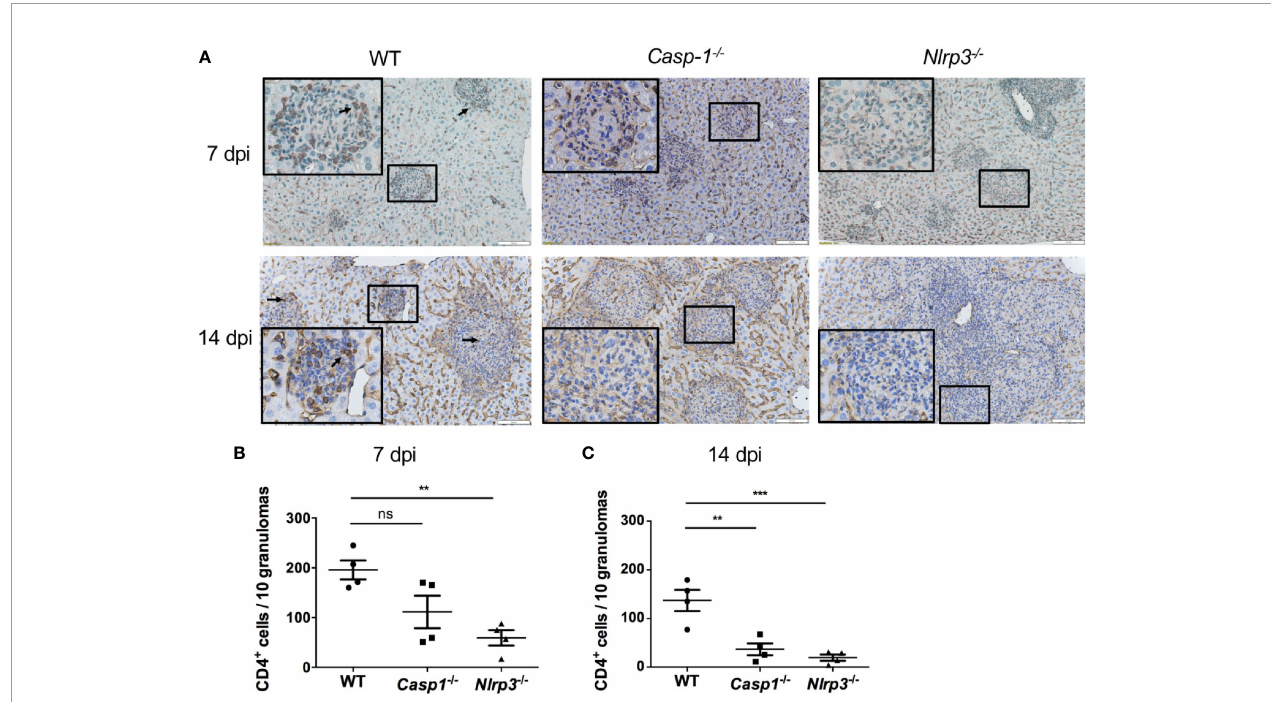
FIGURE 6 | The de fi ciency of Caspase-1 and NLRP3 undermines the recruitment of CD4 T cells into granulomas in murine liver. (A) Representative CD4 staining graphs of murine livers of WT, Casp-1 -/- and Nlrp3 -/- mice intravenously infected with live T. marneffei yeasts (5x10 5 CFU per mouse) at 7 dpi and 14 dpi. Scale bar denotes 100 m m. The insets indicate the magni fi ed area of the smaller box containing granulomas, and the arrow indicates representative CD4 positive cells in the granulomas. (B, C) The number of CD4 positive T cells per 10 granulomas in livers from WT, Casp-1 -/- and Nlrp3 -/- mice at 7 dpi and 14 dpi, and data represent mean ± SEM of n=4 mice, and they are analyzed by one-way ANOVA. ns, not signi fi cant, **p < 0.01, ***p <